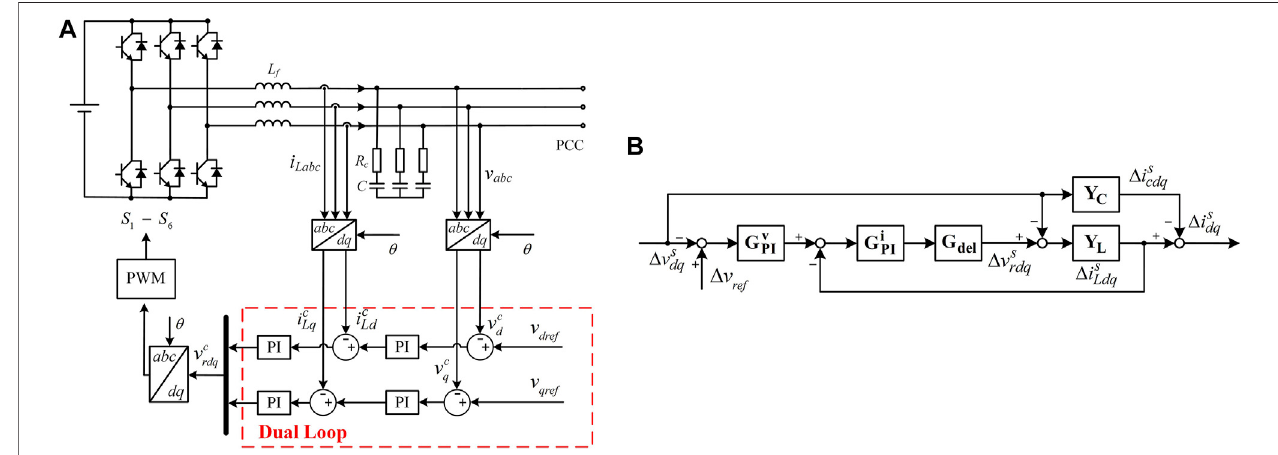
FIGURE 3 | PET con fi guration and impedance mode: (A) con fi guration, (B) impedance model.